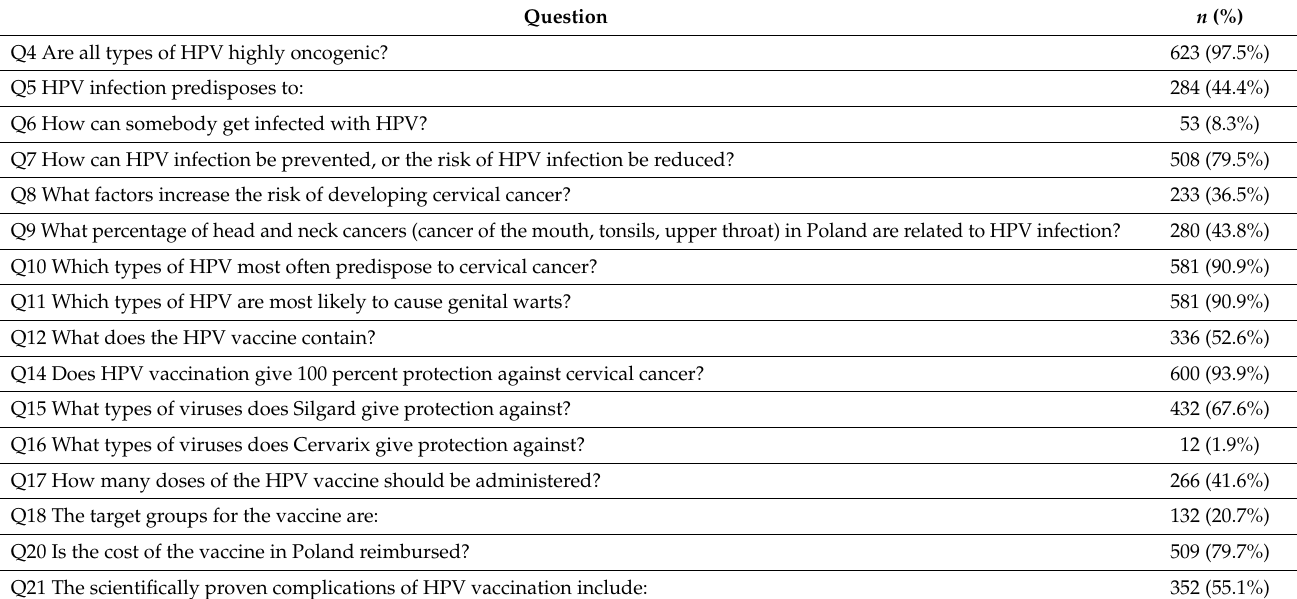
Table 3. Knowledge about HPV vaccination and the HPV virus—correct answers to component